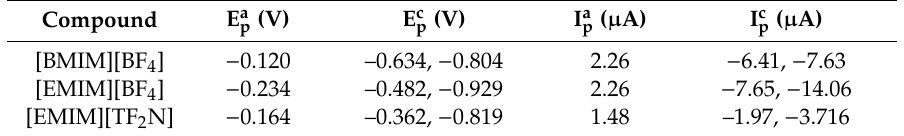
Table 3. Cathodic and anodic peak potential and peak current for ENB obtained from Figure 2b.